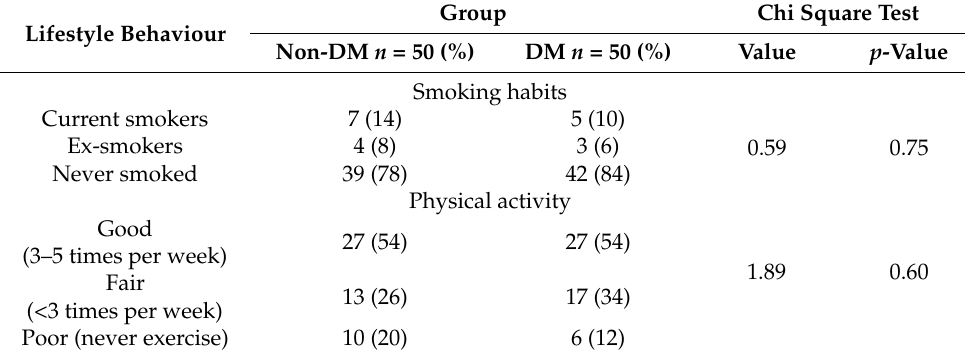
Table 3. Lifestyle behaviour of subjects in non-DM and DM